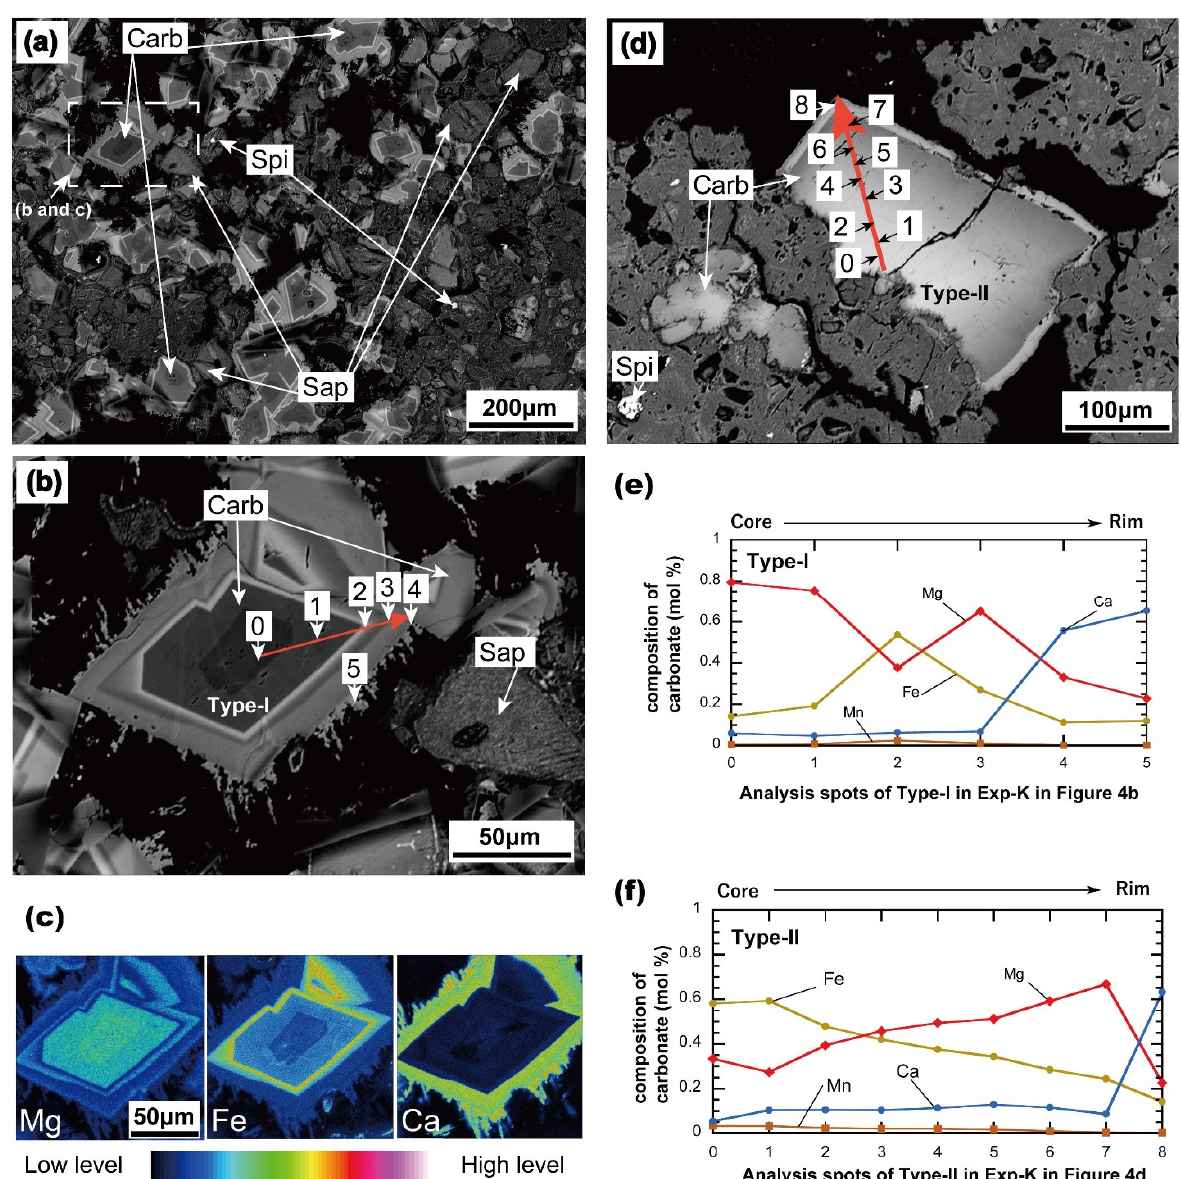
Figure 4. ( a , b , d ) BSE images of the run products. ( c ) Elemental mapping of carbonate minerals (Mg, Fe, and Ca) from Figure 4b and ( e , f ) elemental contents of carbonate minerals in the run products after Exp-K. ( a – d ) Compositional zonation observed in carbonate minerals. The brighter and dark regions correspond to Fe and Mg in carbonate minerals, as revealed by FE-EPMA, respectively. ( b , d ) Fe, Mg, Ca, and Mn contents at each point in type I and type II carbonate minerals in Figure 4c,e, respectively. Abbreviations: Carb—carbonate mineral; Spi—Cr spinel; Sap—saponite.